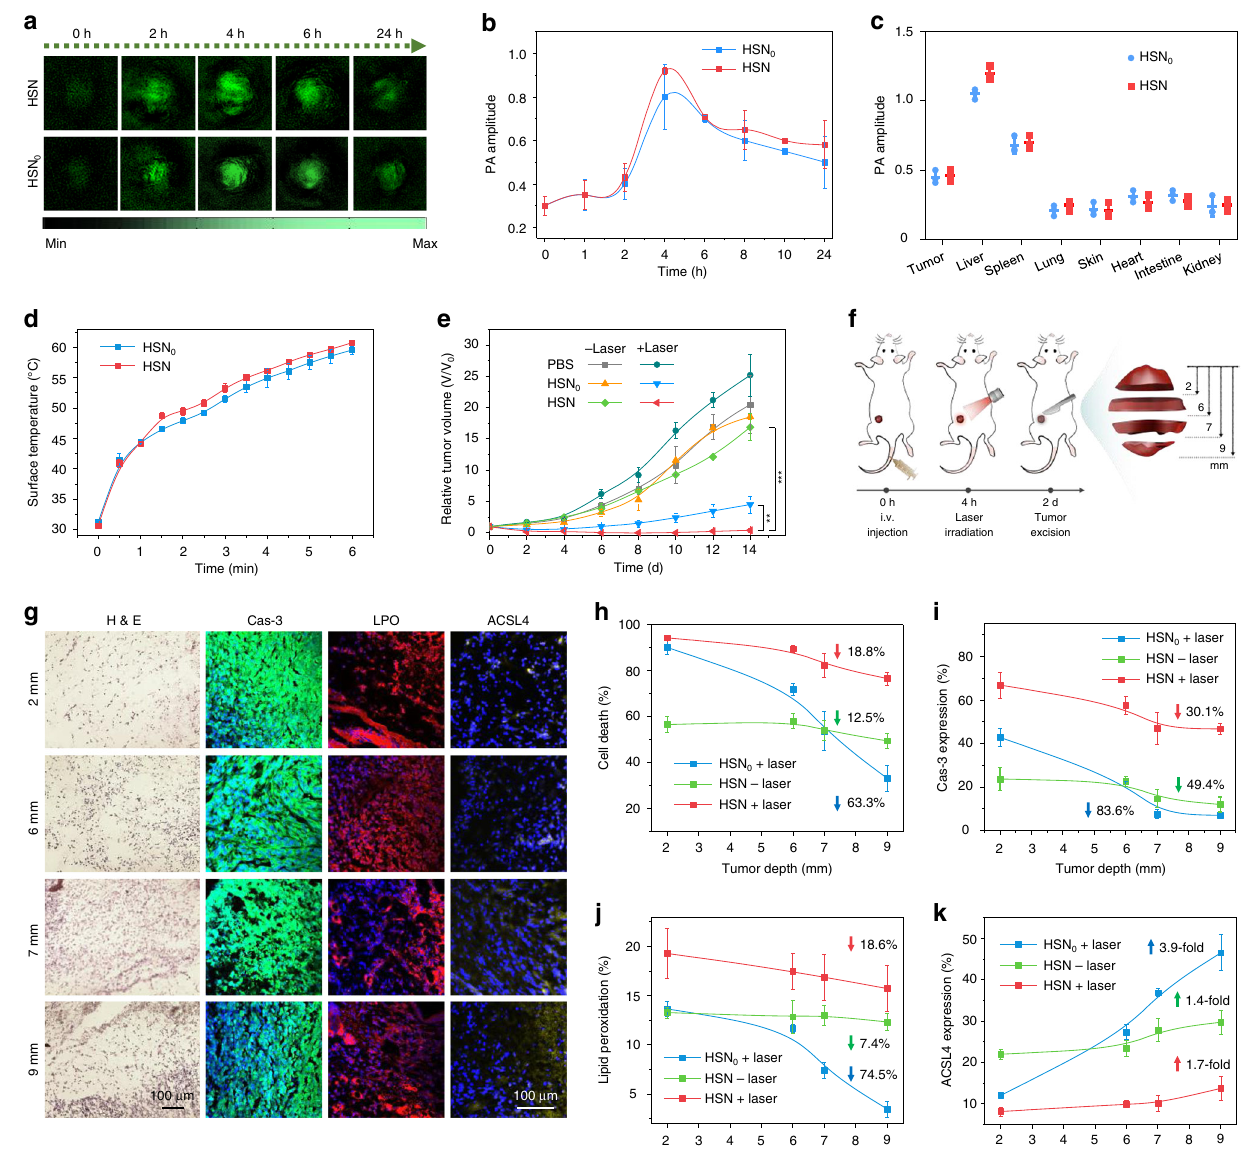
Fig. 4 In vivo NIR-II PA imaging-guided photothermal ferrotherapy. a Time-course NIR-II PA images of tumor region on living mice bearing 4T1-xenograft tumor after intravenous administration of HSN or HSN 0 ([pTBCB] = 250 µ g mL − 1 , 200 µ L per mouse, n = 3). Wavelength: 1064 nm. b Quanti fi cation of PA amplitudes in a ( n = 3). c Biodistribution study of mice in a at 24 h post-administration of HSN or HSN 0 ( n = 3). d Surface tumor temperature of 4T1 tumor-bearing mice upon 1064 nm photoirradiation (1 W cm − 2 , 6 min) at 4 h after intravenous administration of HSN or HSN 0 ([pTBCB] = 250 µ g mL − 1 , 200 µ L per mouse, n = 3). e Tumor growth curves of mice after photothermal ferrotherapy and monotherapies ( n = 3). P -values were calculated by Student ’ s two-sided t -test. ** P < 0.01, *** P < 0.001 ( n = 3). f Scheme of photothermal depths of tumor. g H&E staining and immuno fl uorescent staining (Cas-3, LPO, and ACSL4) images of tumor sections at different photothermal depths after monotherapies or photothermal ferrotherapy. Cas-3, LPO, and ACSL4 staining was indicated with green, red, and yellow false colors, respectively. h – k Quanti fi cation of cell death percentage ( h ), Cas-3 expression ( i ), LPO extent ( j ), and ACSL4 expression ( k ) of tumor sections at different photothermal depths after monotherapies or photothermal ferrotherapy. Upwards or downwards arrows indicated the increased or decreased percentage at 9 mm relative to 2 mm. Error bars indicated standard deviations of three independent